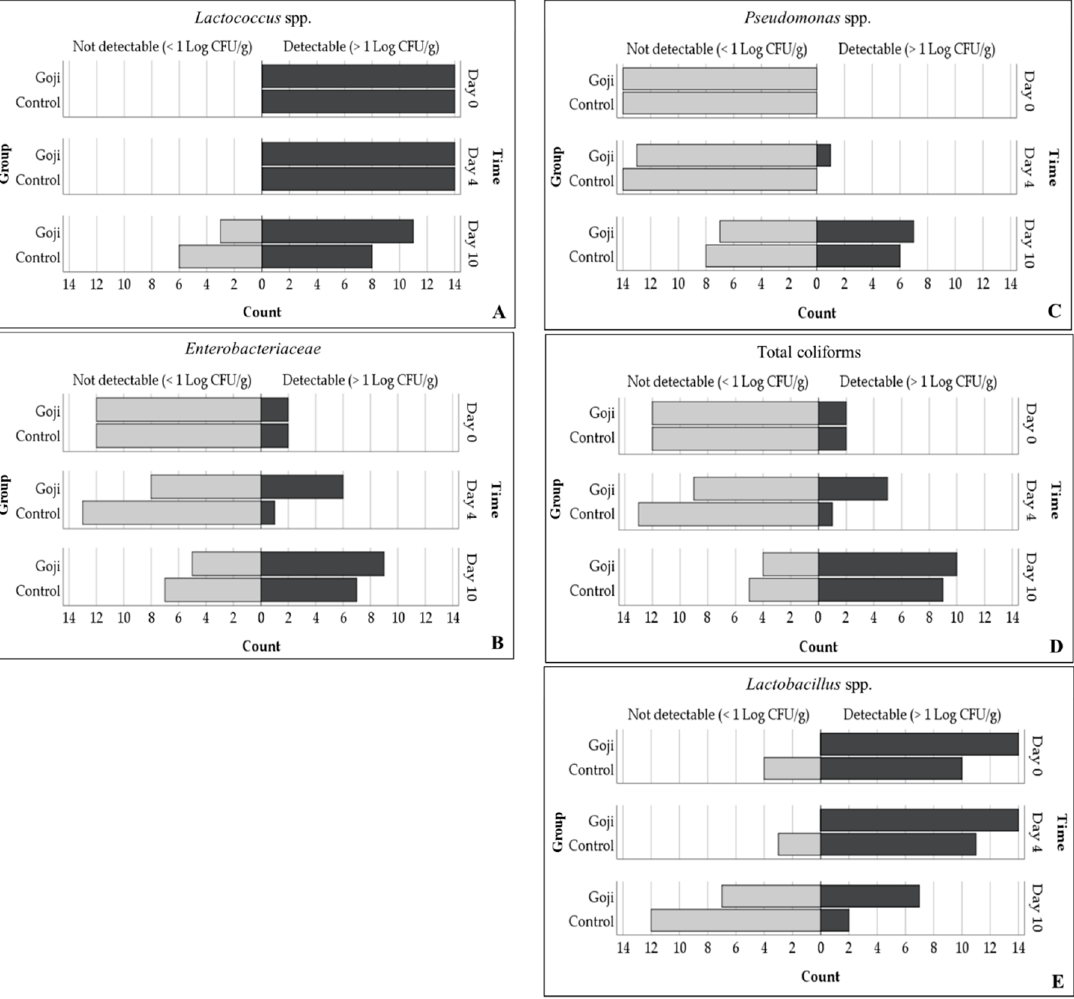
Figure 3. Population pyramids that show the absolute number of rabbit’s meat units containing colonies of Lactococcus spp. ( A ), Enterobacteriaceae ( B ), Pseudomonas spp. ( C ), total coliforms. ( D ), and Lactobacillus spp. ( E ). The limit of detection was 1 Log